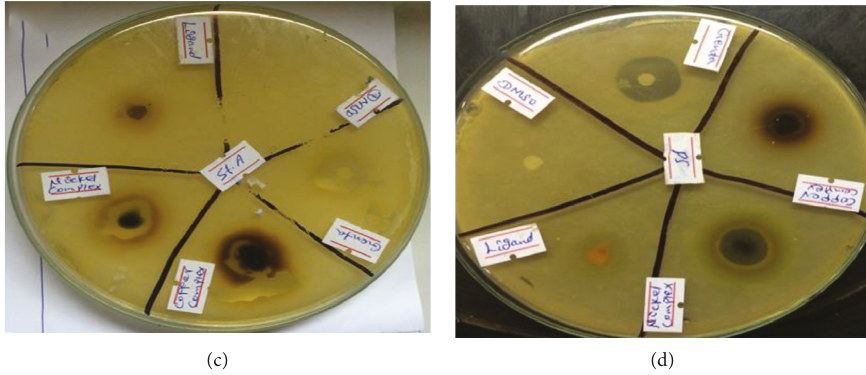
Figure 11: Inhibition of Escherichia coli (a), Bacillus subtilis (b), Staphylococcus aureus (c), and P. aeruginosa